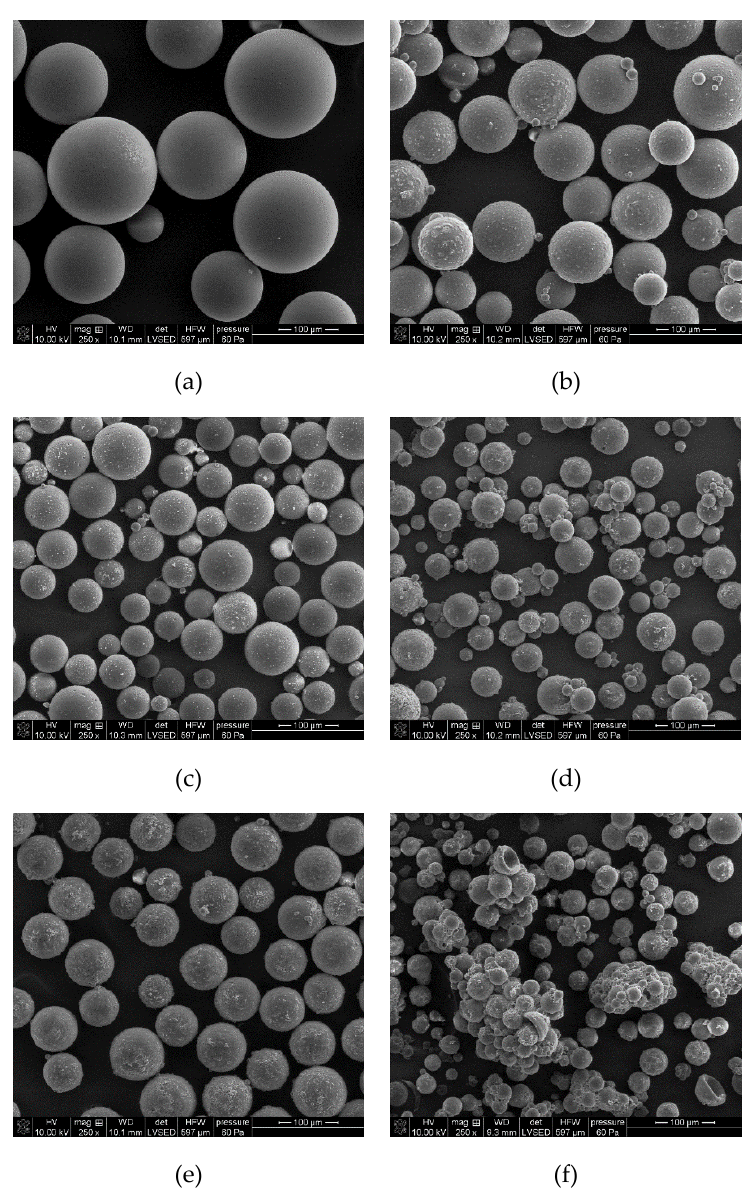
Figure 5. SEM images of the obtained microspheres. The scale bar is the same for all images. ( a ) EGDMA + St, ( b ) EGDMA + ST + 1L, ( c ) EGDMA + St + 2L, ( d ) EGDMA + St + 3L, ( e ) EGDMA + St + 4L, ( f ) EGDMA + St + 5L.